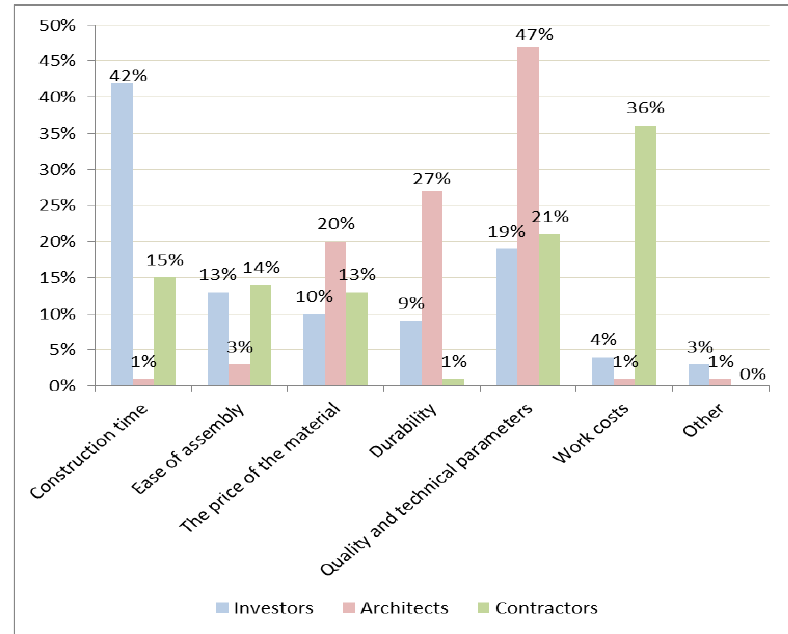
Figure 2. Factors that determine the choice of precast concrete technology.